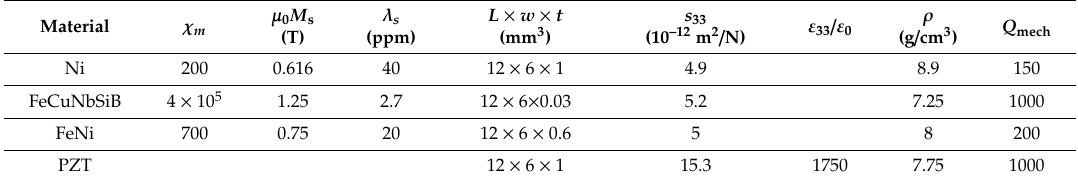
Figure 7. The theoretical and experimental α ME, r vs. H dc for the FeCuNbSiB / Ni / PZT composite. Table 1. Material parameters of the FeCuNbSiB ribbon, Ni plate, FeNi plate, and the Pb(Zr 1 − x Ti x )O 3 (PZT) plate.